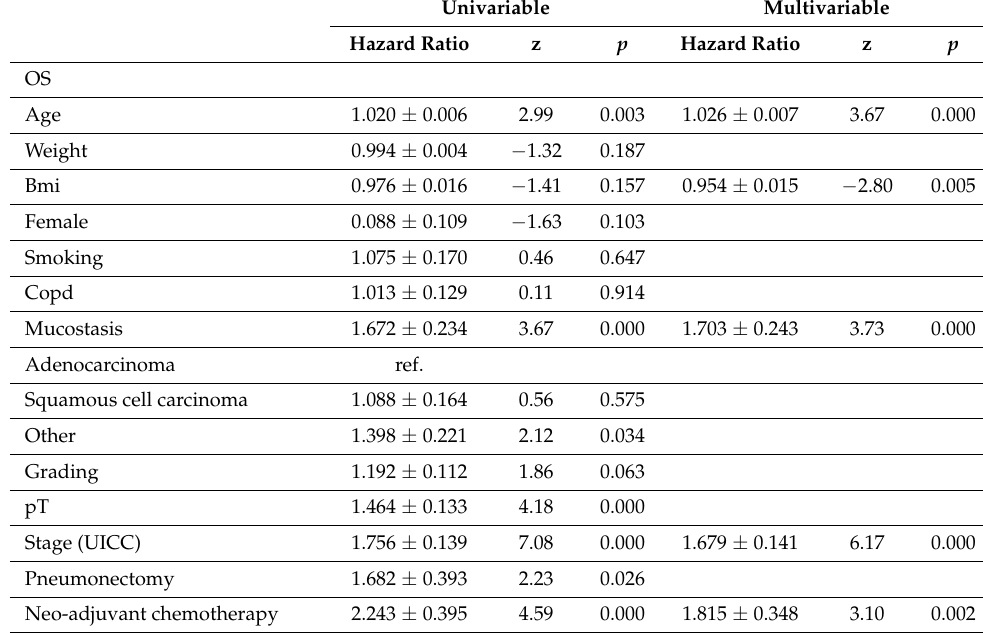
Table 4. Univariable and multivariable analyses between OS, CSS and RFS and clinic-pathological characteristics of 342 patients undergoing curative resection for NSCLC. Abbreviations: OS: overall survival, CSS: cancer specific survival, RFS: recurrence free survival, COPD: Chronic obstructive pulmonary disease, NSCLC: non-small cell lung cancer, BMI: Body Mass Index, T: T stage (tumor invasion), UICC: International Union against Cancer, kg: